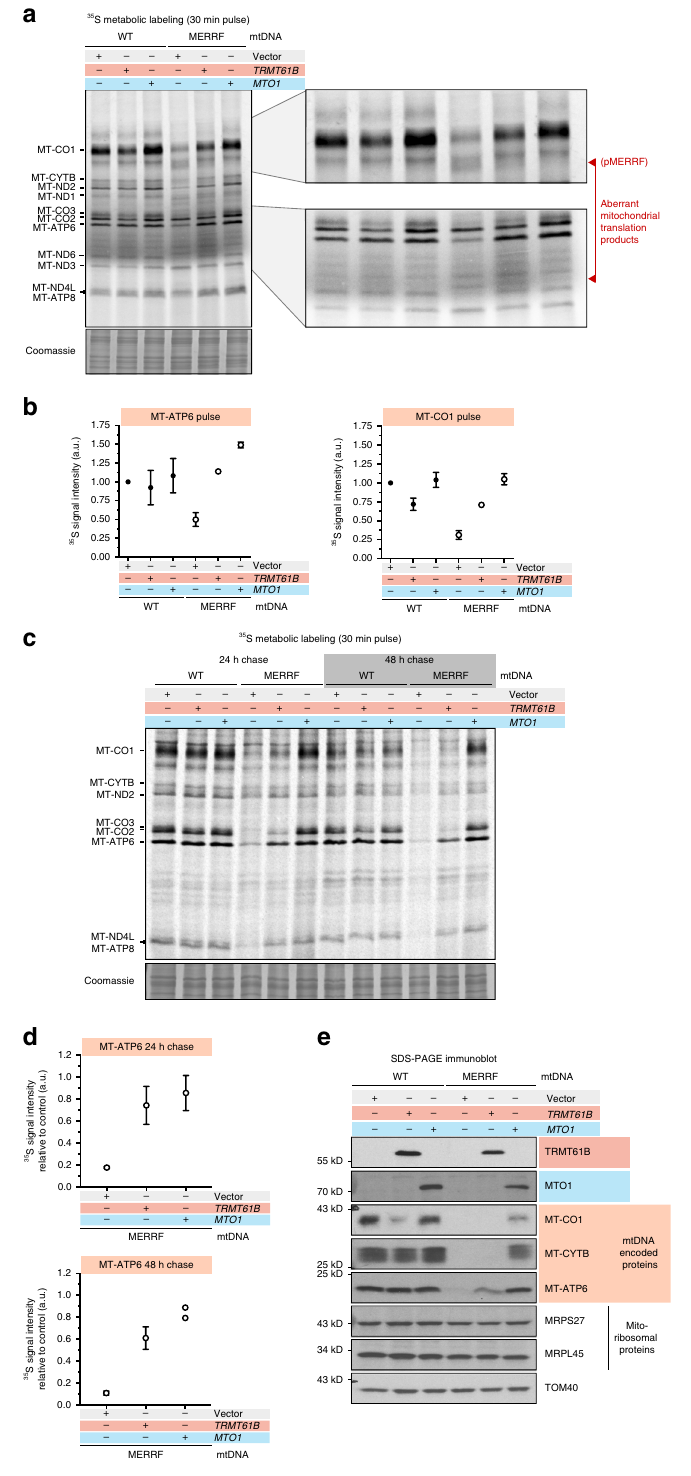
Fig. 5 tRNA Lys RNA modi fi cations reveal speci fi c effects to translation fi delity. a A representative 35 S pulse (30 min) metabolic labeling into mitochondrial protein synthesis of human myoblasts stably homoplasmic for the indicated mitochondrial DNA transduced by retrovirus with the indicated cDNAs. Aberrantly sized labeled polypeptides are indicated. b Quanti fi cation of 35 S incorporation into selected mitochondrial proteins during a 30 min pulse (from a ). Data are represented as mean + / − S.D. from three biological experiments. c A representative 24 and 48 h cold chase following a 30 min 35 S pulse metabolic labeling of mitochondrial protein synthesis in human myoblasts. d Quanti fi cation of MT-ATP6 stability in the chase relative to wild-type cells transduced with an empty vector. Data is mean + / − S.D. from three biological experiments except for MTO1 at 48 h, where only the data from two independent experiments are shown. e Immunoblotting of whole-cell lysates from human myoblasts homoplasmic for the indicated mitochondrial DNA transduced by retrovirus with the indicated cDNAs decorated with the indicated antibodies. Representative data of multiple independent